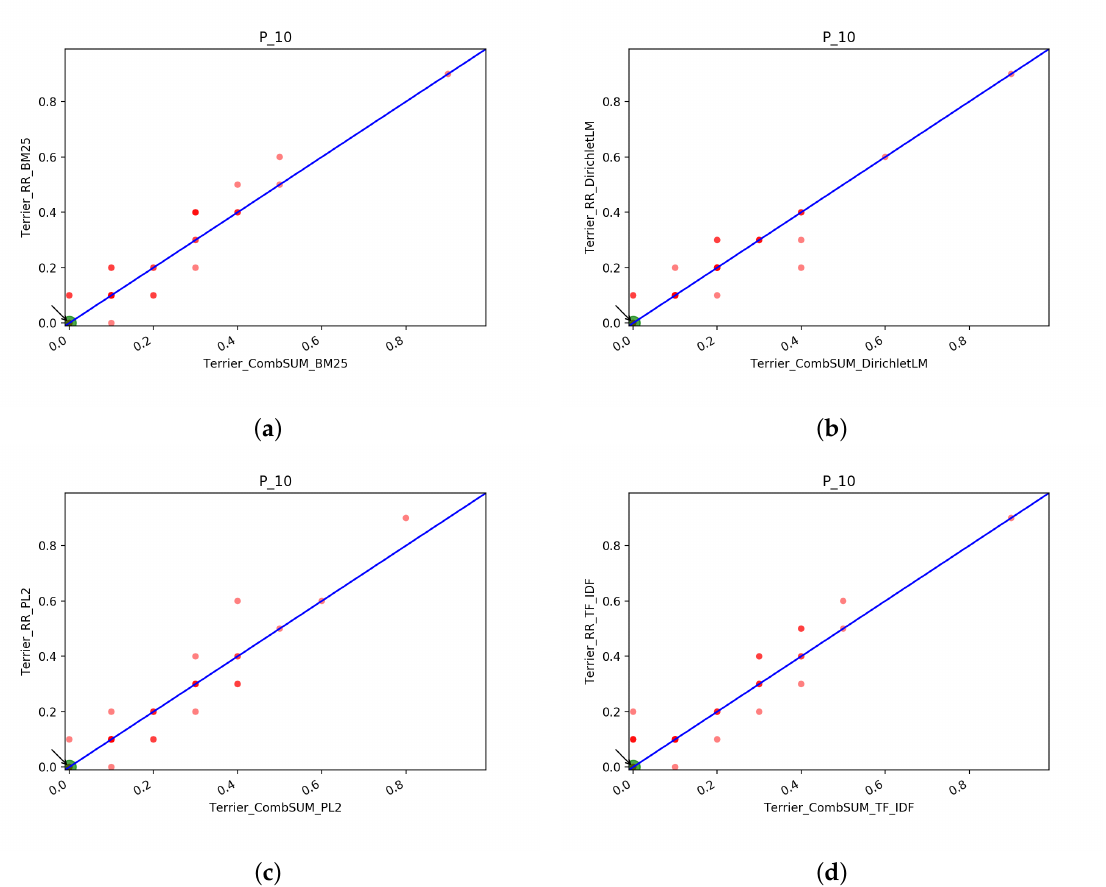
Figure 21. T1: scatter plots of P@10 of the fusion of the models with different indexes: ( a ) CombSUM vs. RR fusion of the Terrier runs with BM25 weighting scheme, ( b ) CombSUM vs. RR fusion of the Terrier runs with DirichletLM weighting scheme, ( c ) CombSUM vs. RR fusion of the Terrier runs with PL2 weighting scheme, ( d ) CombSUM vs. RR fusion of the Terrier runs with TF-IDF weighting